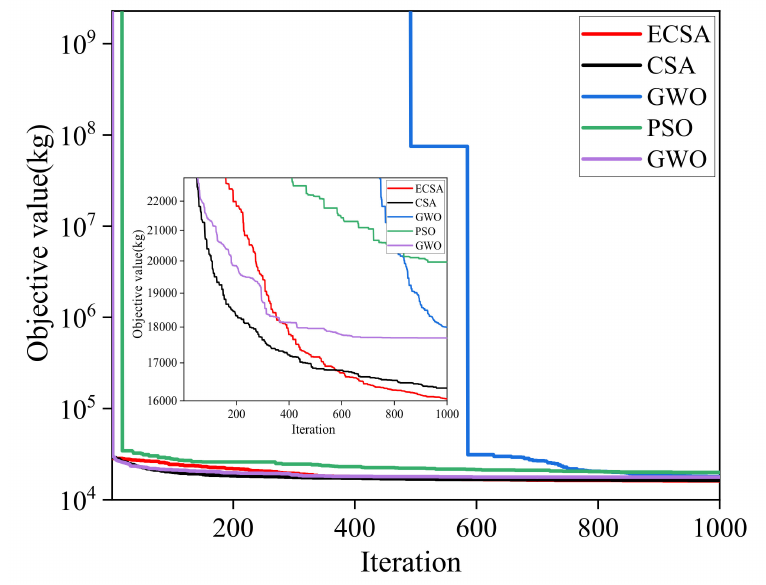
Figure 5. Iterative convergence diagram of different